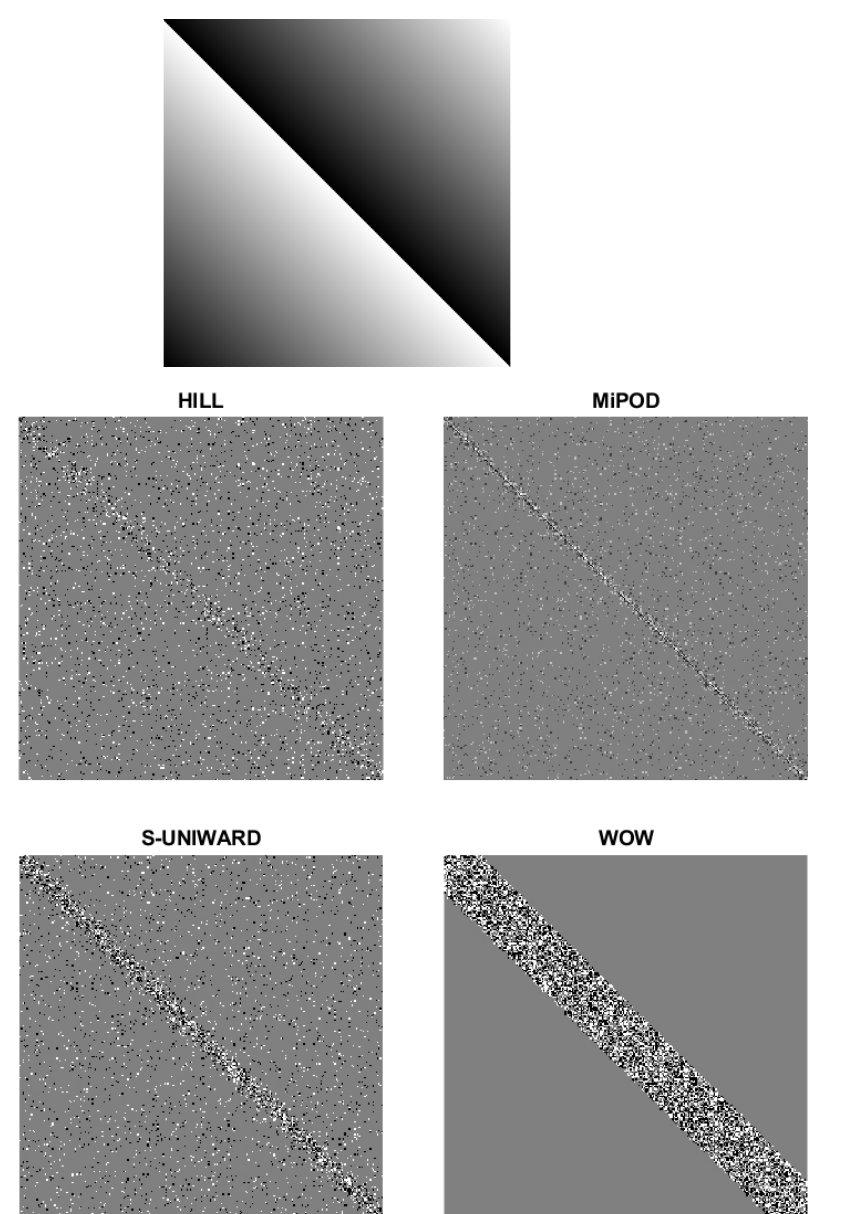
Figure 2. CG cover image and residual arrays of cover ‐ stego images.